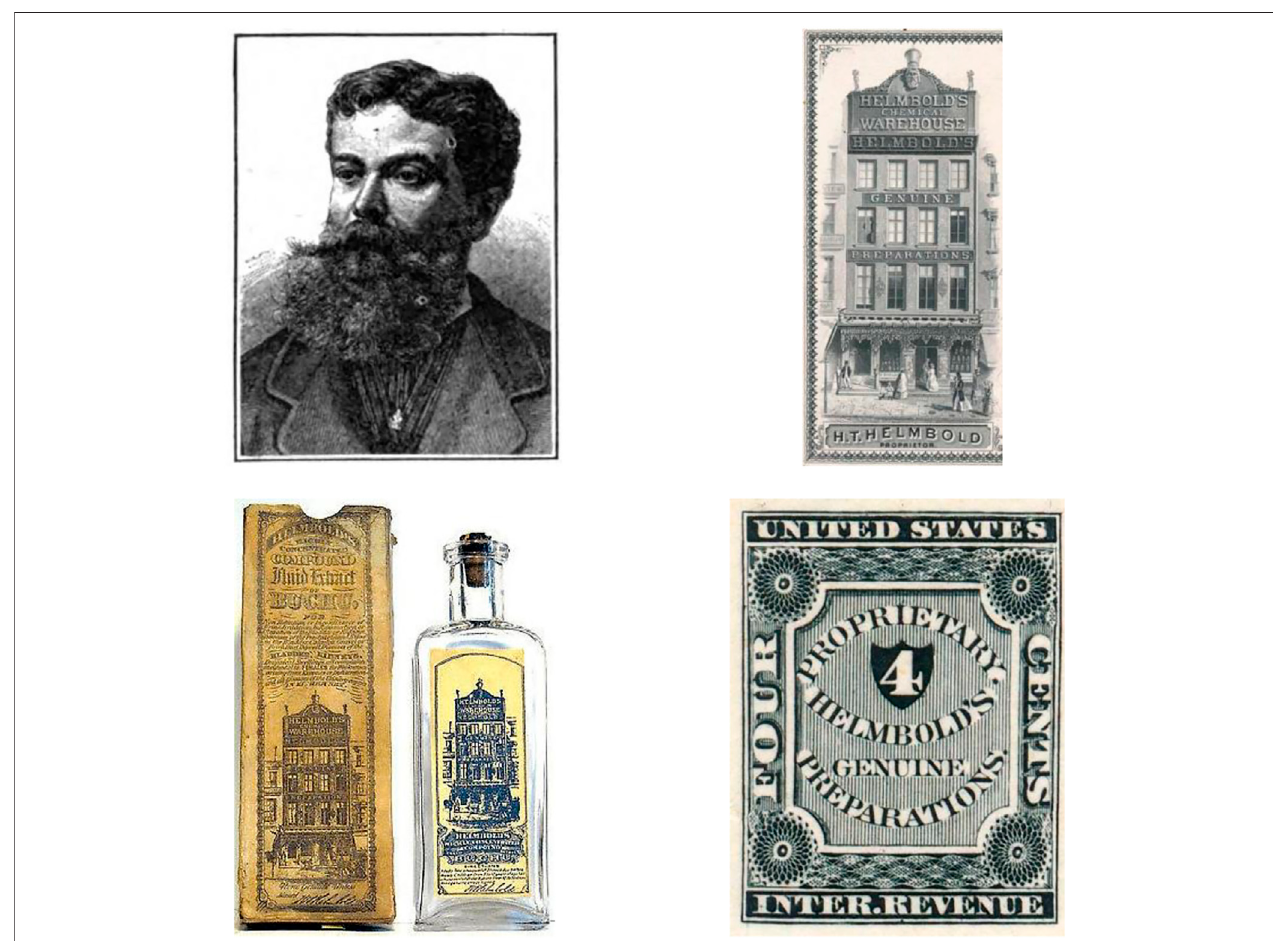
FIGURE 4 | Helmbold ~1871, one of his storefronts, Helmbold ’ s extract of buchu, his proprietary postage stamp.